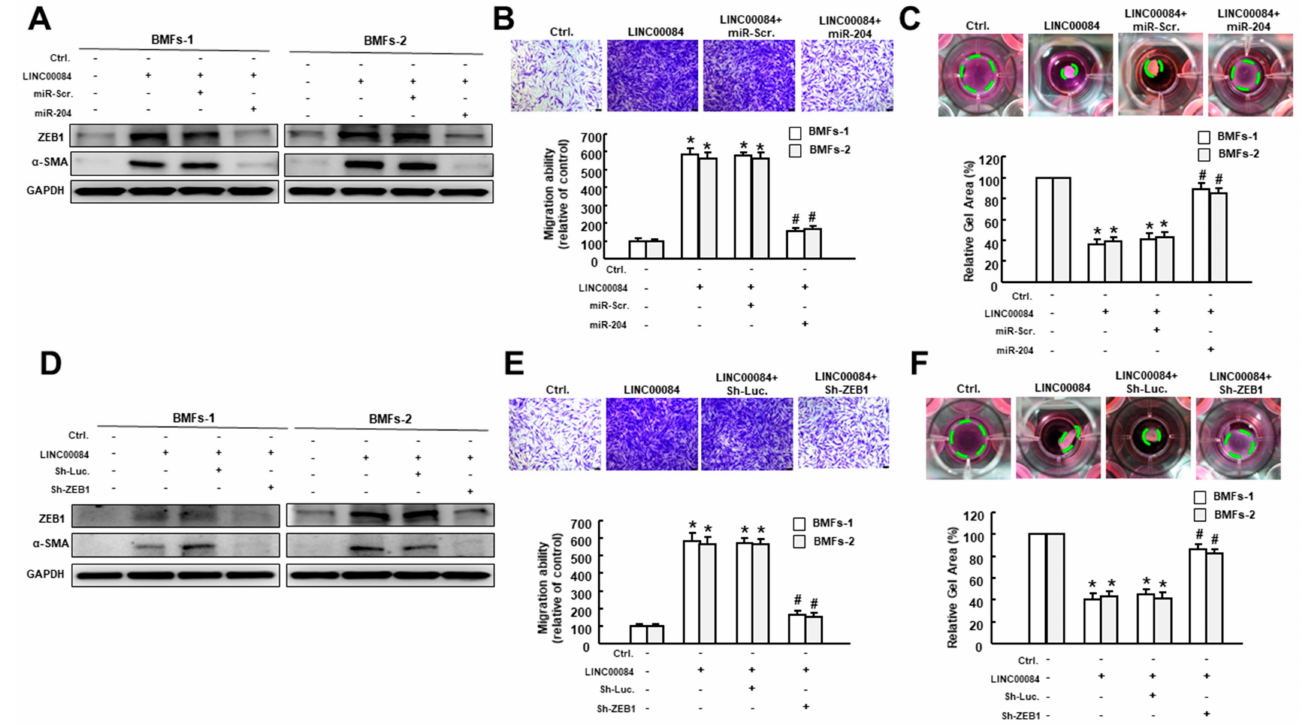
Figure 6. LINC00084 promotes myofibroblast transdifferentiation of BMFs via regulation of miR-204/ZEB1 axis. ( A ) Protein expression of ZEB1 and α -SMA, ( B ) migration ability and ( C ) collagen gel contraction in BMFs co-transfected with LINC00084 overexpression plasmids, miR-Scr., or miR-204 mimics; ( D ) protein expression of ZEB1 and α -SMA, ( E ) migration ability, and ( F ) collagen gel contraction in BMFs co-transfected with LINC00084 overexpression plasmids, Sh-Luc., or Sh-ZEB1. Results are means ± SD of triplicate samples from three experiments. * p < 0.05 compared to Ctrl. group. # p < 0.05 compared to the LINC00084 overexpression